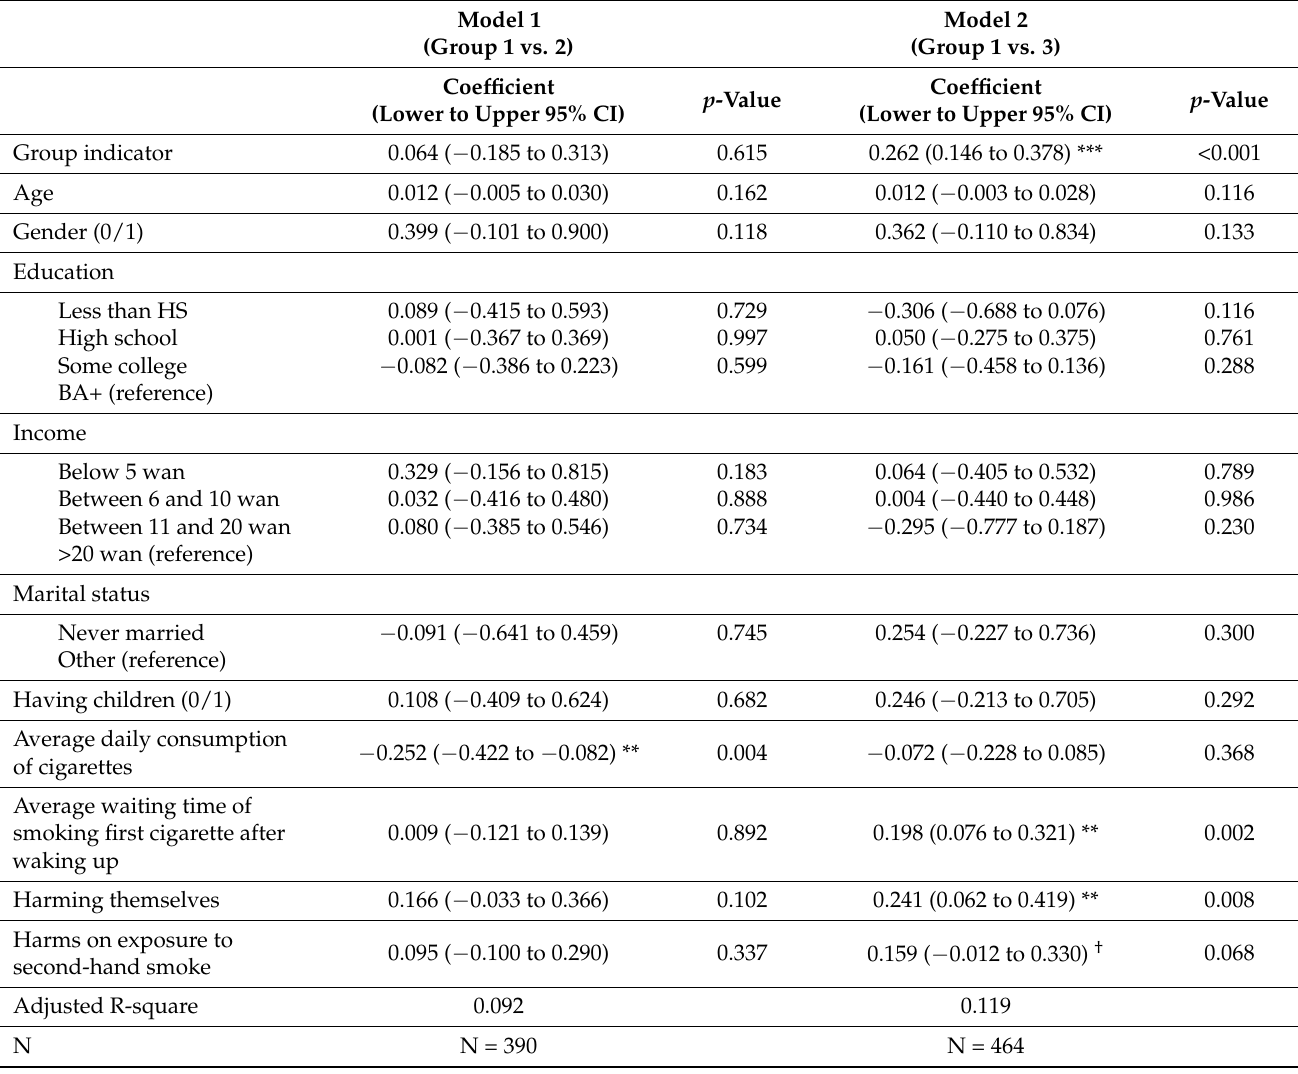
Table 3. Predicting Intention to Quit Smoking with Pictorial Warning Depictions.